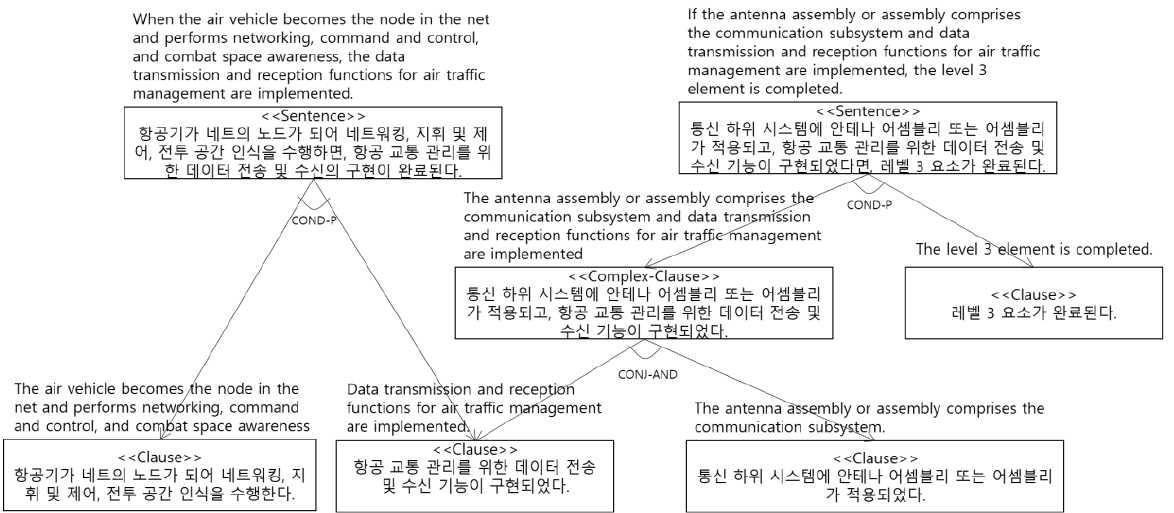
Figure 11. Requirement specifications in the missile system. Figure 12 is the C3Tree Model generated from the requirement specification. Four <<Clause>> were generated.